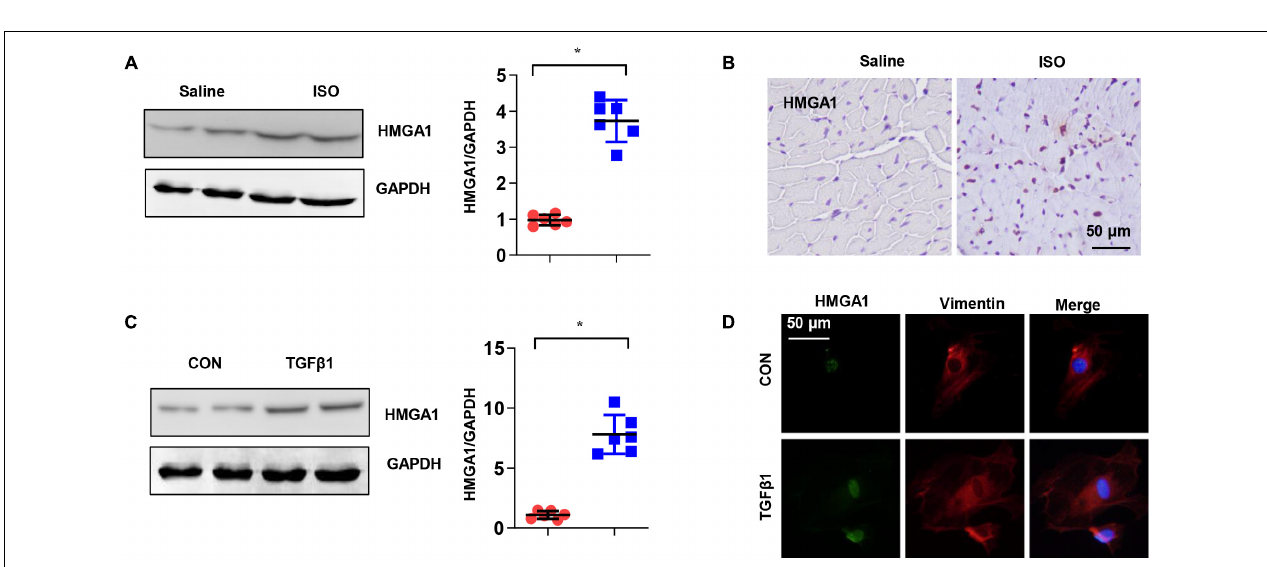
Frontiers in Cell and Developmental Biology |